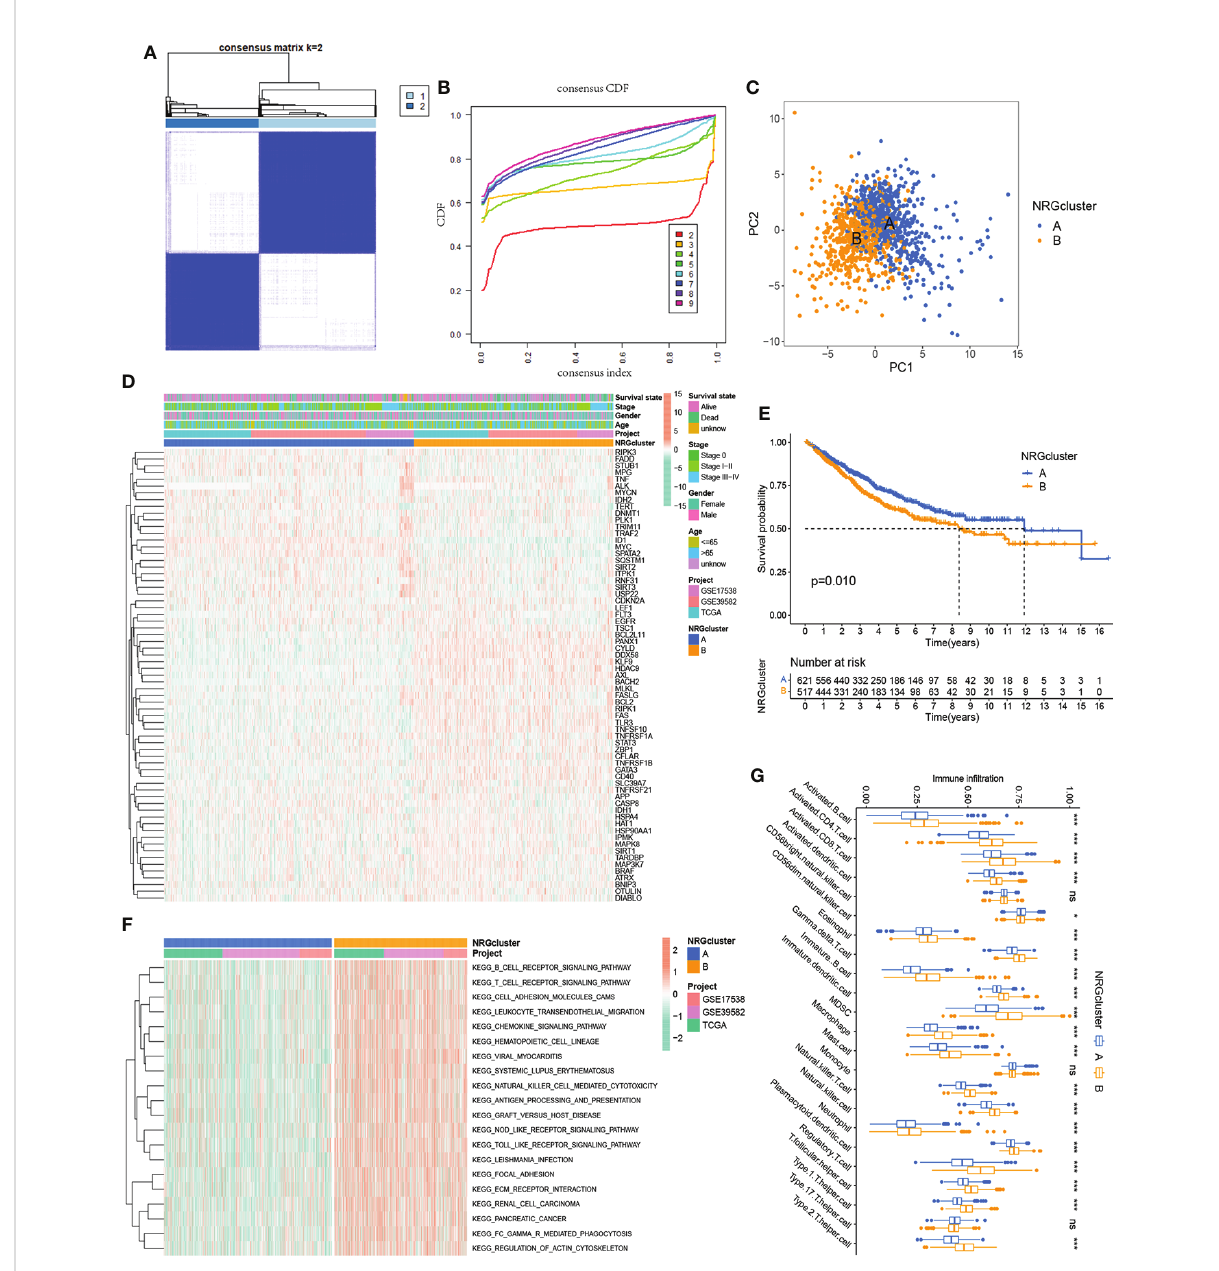
FIGURE 2 Identi fi cation of two NRG subtypes. (A) Consensus matrix heatmap of sample clustering under k = 2. (B) Cumulative distribution function (C, D, F) curve with the number of subtypes k = 2 to 9. (C) Principal component analysis showing the difference in transcriptomes between the two NRG subtypes. (D) Heatmap showing differences in the expression of 67 NRGs between distinct NRG clusters. (E) Survival analysis of patients in two NRG clusters. (F) GSVA enrichment analysis showing the potential biological change between distinct NRG clusters. (G) TME immune-in fi ltrating characteristics and transcriptome traits of two NRG clusters. ***P < 0.001; *P < 0.05; ns P ≥